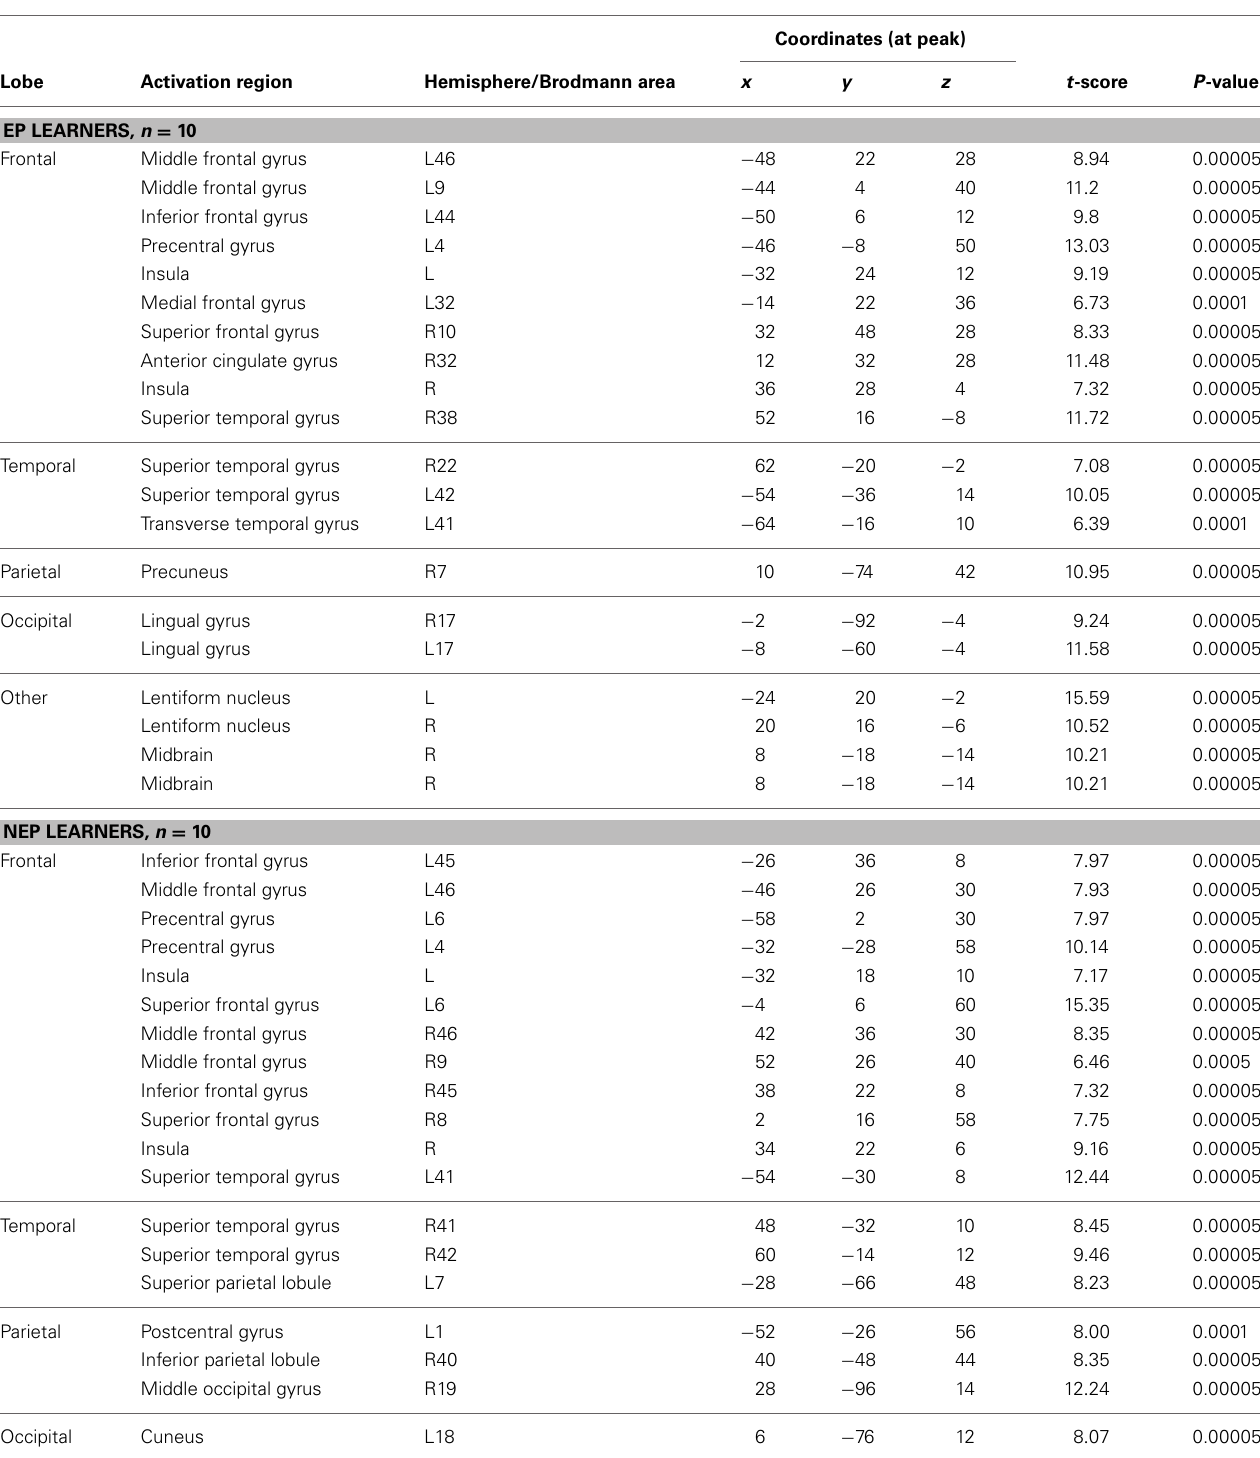
Table 1 | Univariate activity during new language